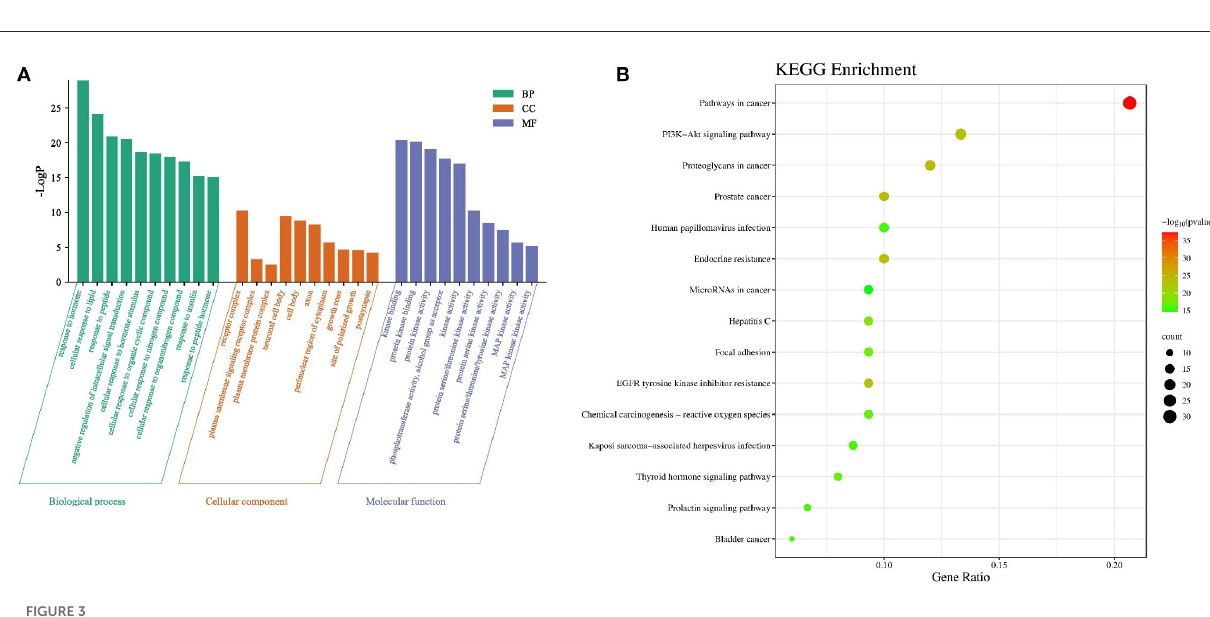
FIGURE3 (A, B) GO and KEGG enrichment analysis